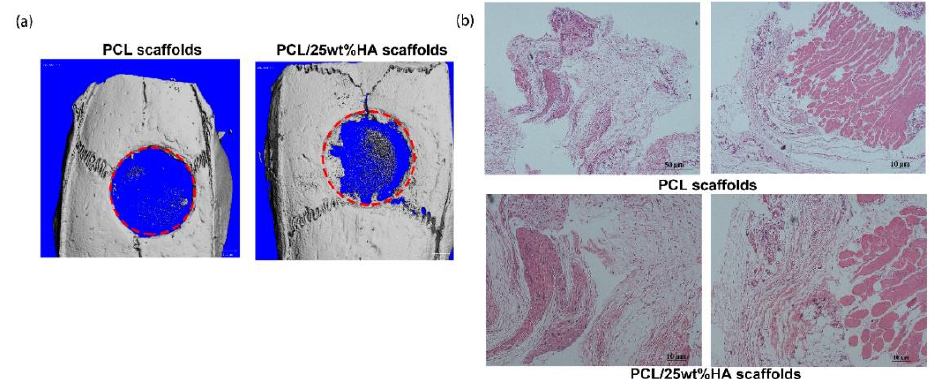
Figure 8. In vivo micro-CT images and histological analysis in skull defect. ( a ) Micro-CT of the skull defect repair in rats with pure PCL and PCL/25%HA scaffolds at 4 weeks; ( b ) H&E staining of the muscle on the back of the rats at 4 weeks post-surgery (HE ×300).